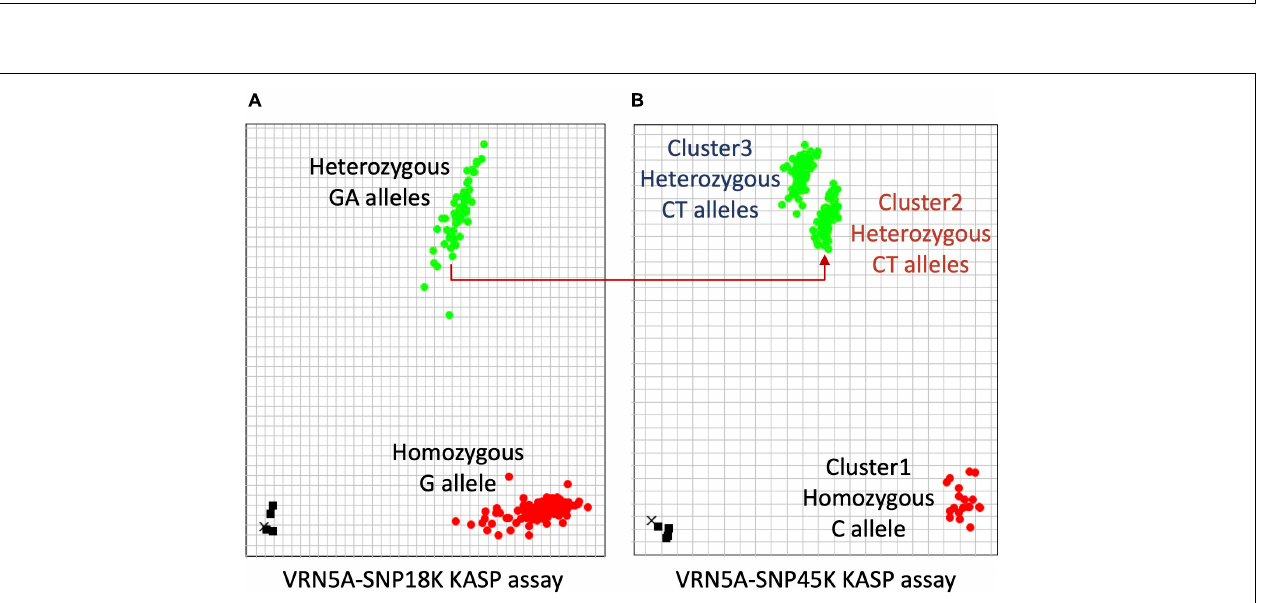
Frontiers in Plant Science |